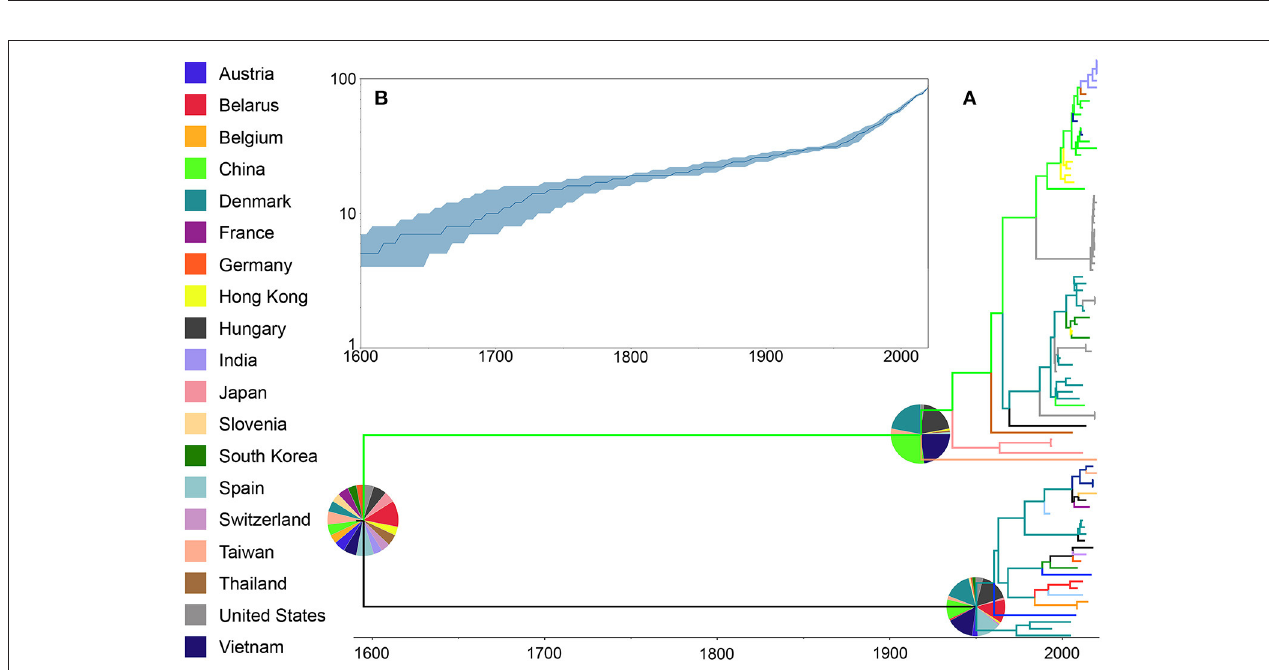
FIGURE 1 | Global annual scientific production involving whole genome sequences (blue) and single genes (orange) where A represents the number of publications per country of whole genome-related research, B represents the global annual scientific production of whole genome-related research, C represents the number of publications per country of single genes-related research, and D represents the global annual scientific production of single genes-related research.